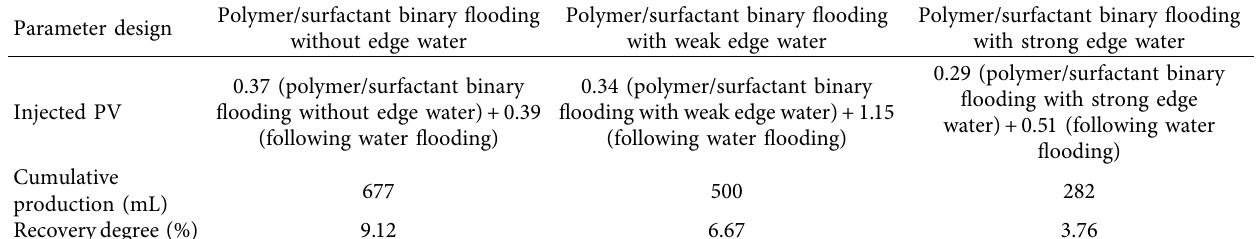
Table 3: Production data of each experimental stage.